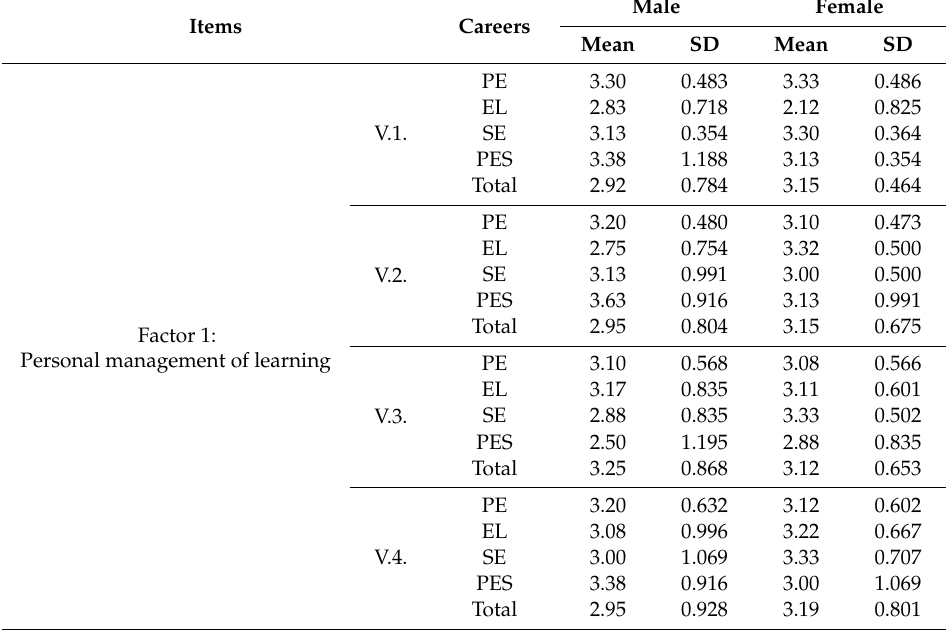
Table A1. Means and standard deviations for QPLEC by careers and sex. Items